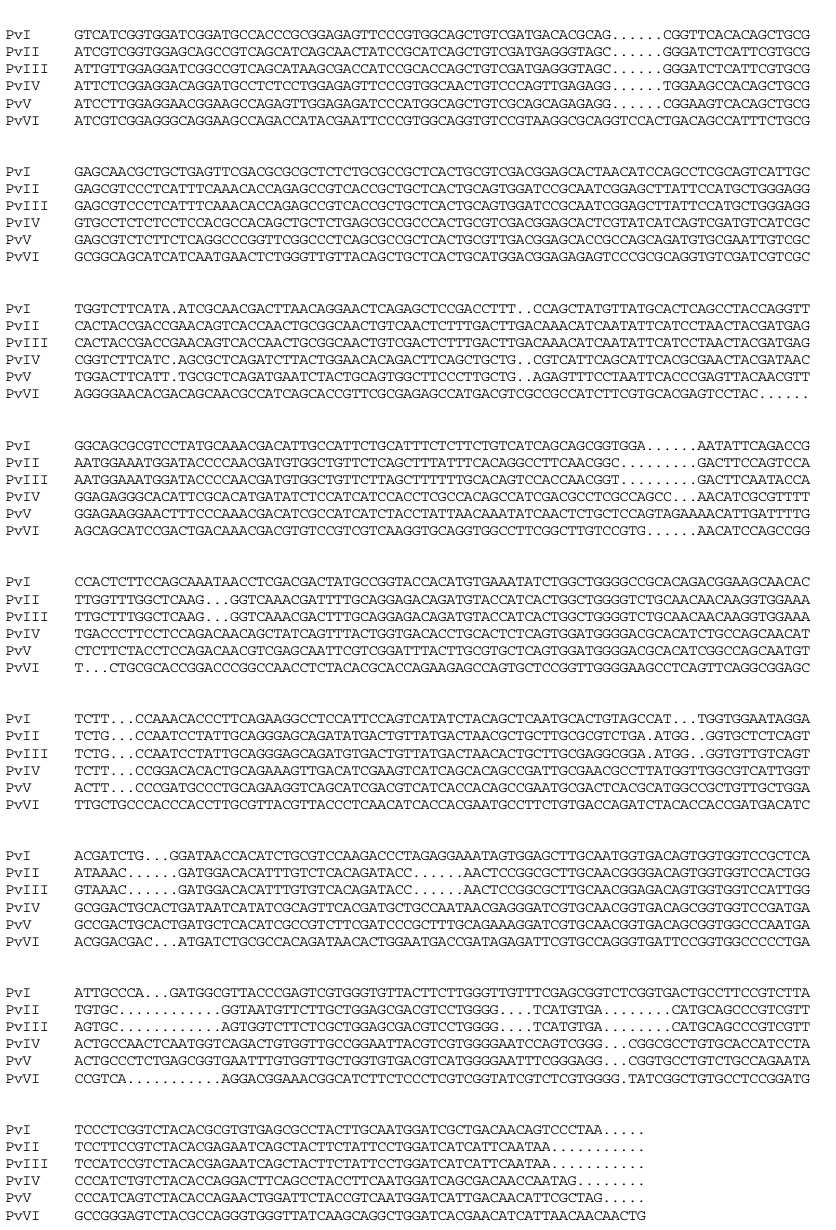
Figure 14. The gene sequences of six proteases, Pv I– Pv VI, from P . vulgaris .